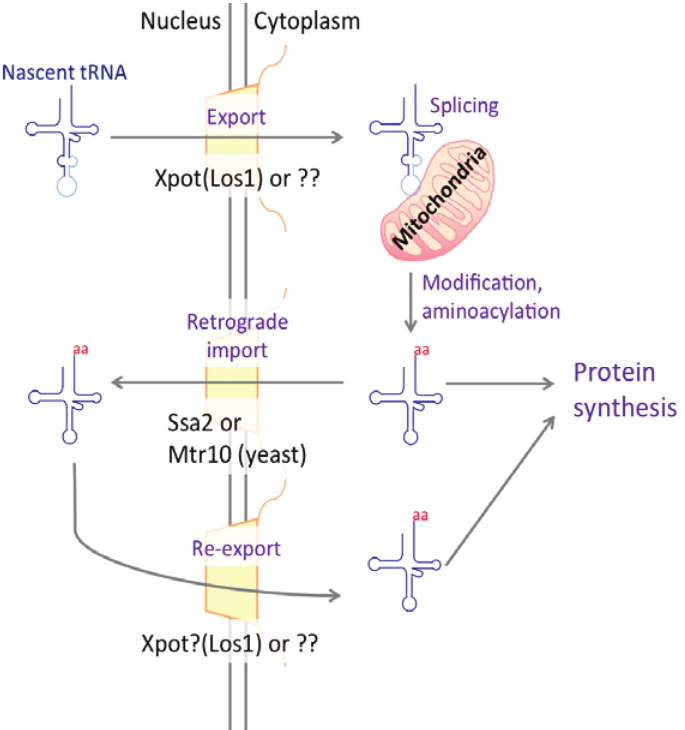
Figure 4. Transportation of tRNA. Nascent tRNA is exported to the cytoplasm and processed into mature tRNA, which remains in the cytoplasm and can function in protein